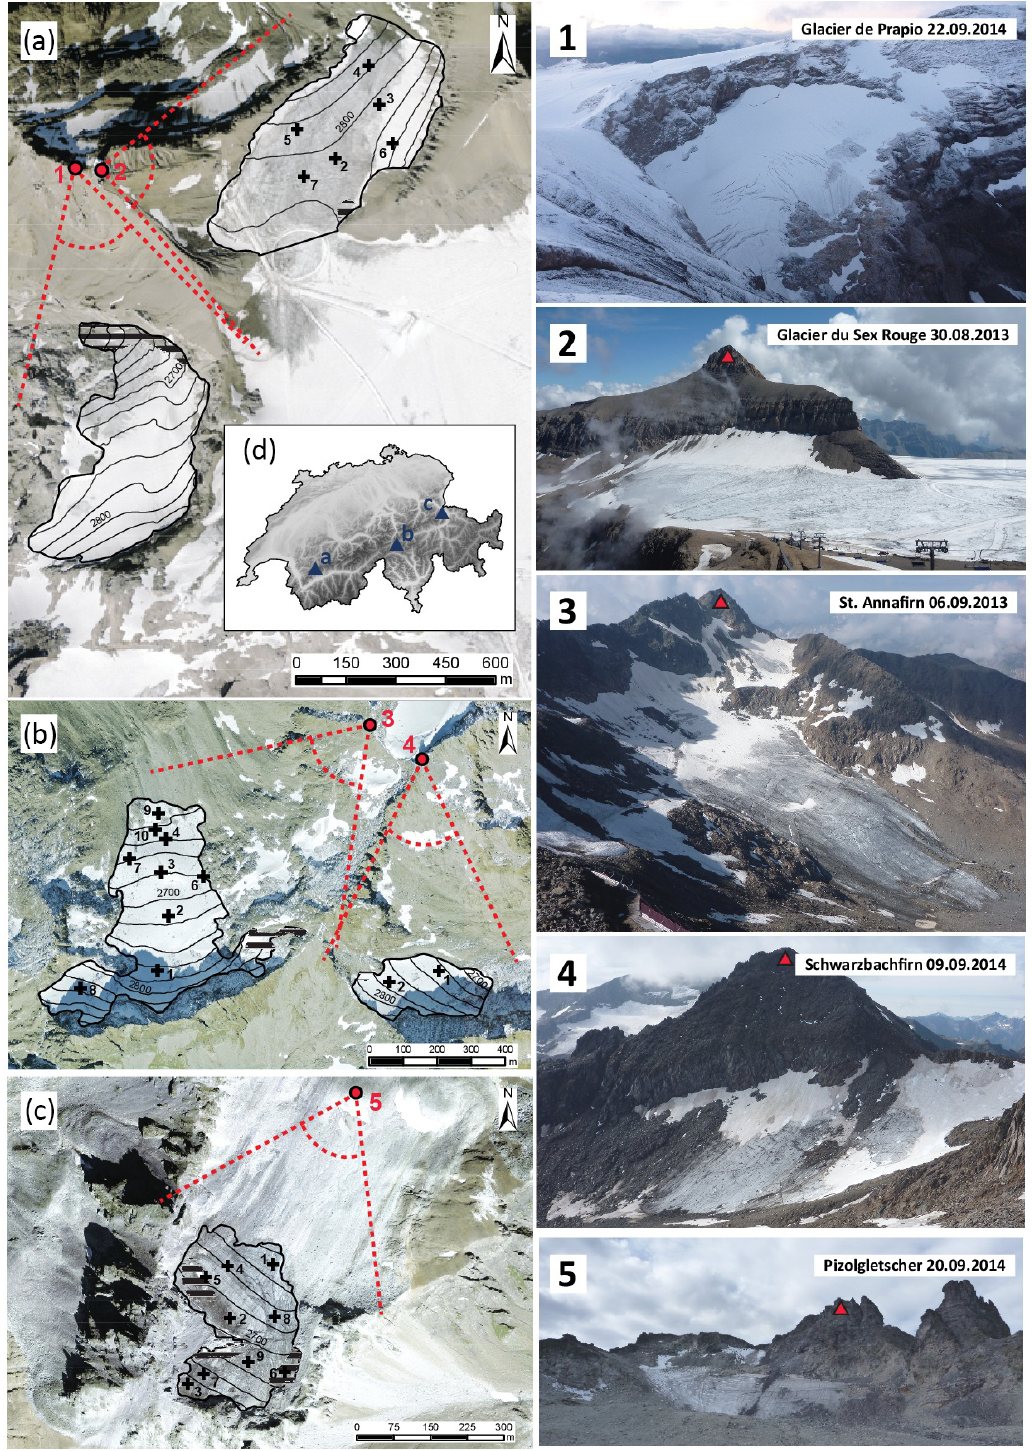
Figure 1. Overview of study sites. (a) Glacier de Prapio and Glacier du Sex Rouge, (b) St. Annafirn and Schwarzbachfirn, and (c) Pizol- gletscher. The locations of the surveyed glaciers in the Swiss Alps is given in (d) . Scan positions and horizontal view angles of the TLS surveys are shown by red dots and red dashed lines. Red numbers (on left side) correspond to individual photographs of the study glaciers (on right side) which were taken from the respective scan positions. Red triangles on the photographs refer to summits mentioned in the text. Black dashed areas indicate lidar shadow, and black crosses the locations of ablation